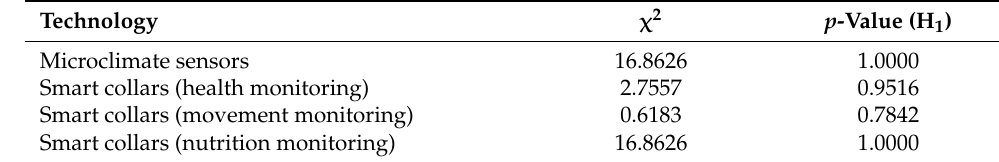
Table 3. The results of statistical evaluation for sensors and IoT in livestock production.